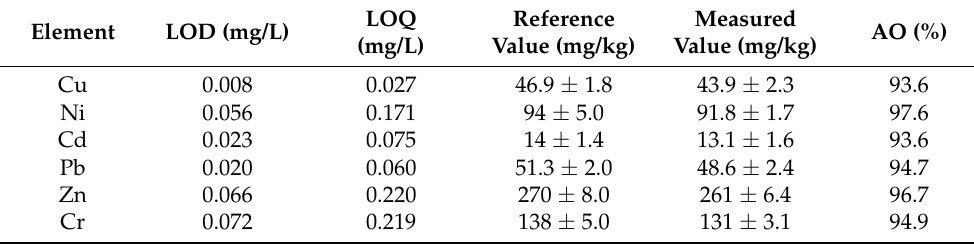
Table 2. LOD, LOQ and accuracy for the analyzed